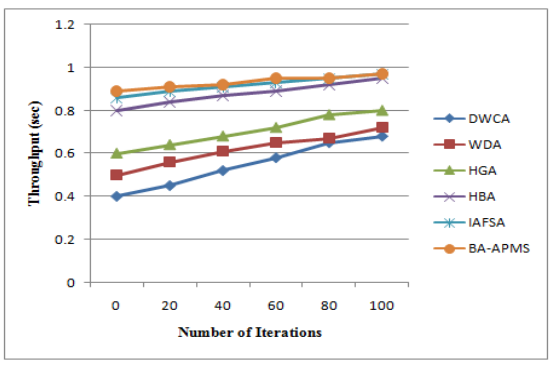
Figure 2. Throughput Comparison